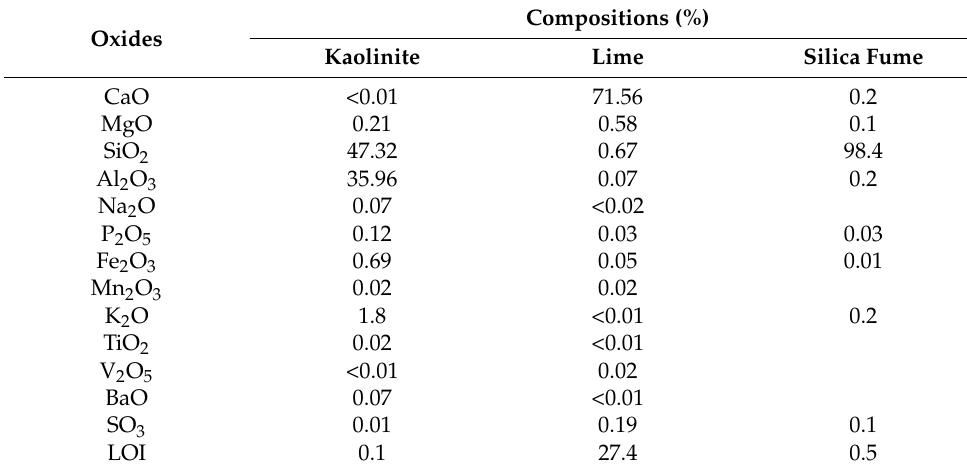
Table 1. Oxide composition of kaolinite, lime, and silica fume.